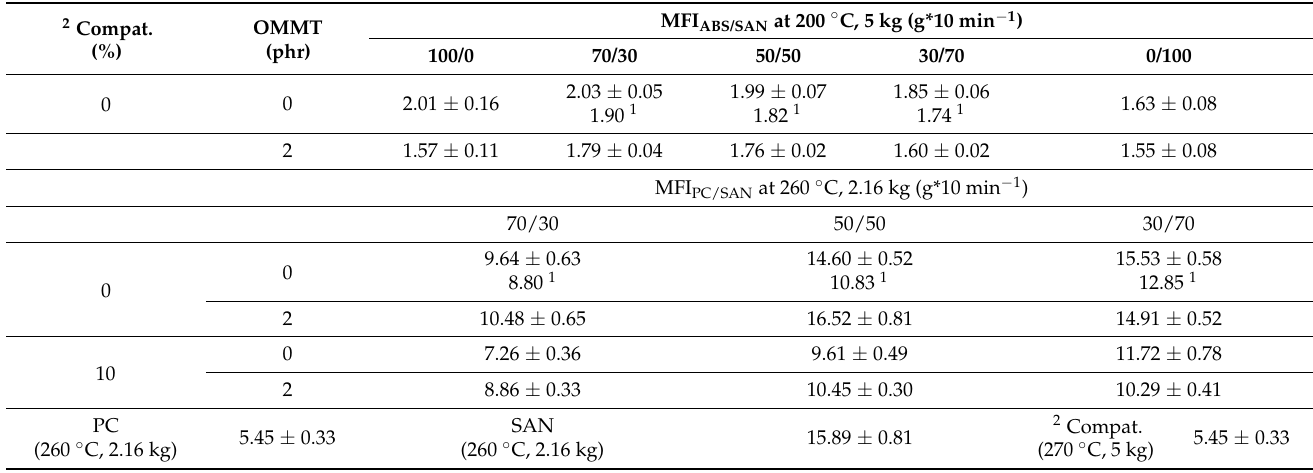
Table 1. Melt Flow Index of ABS/SAN and PC/SAN blends and their